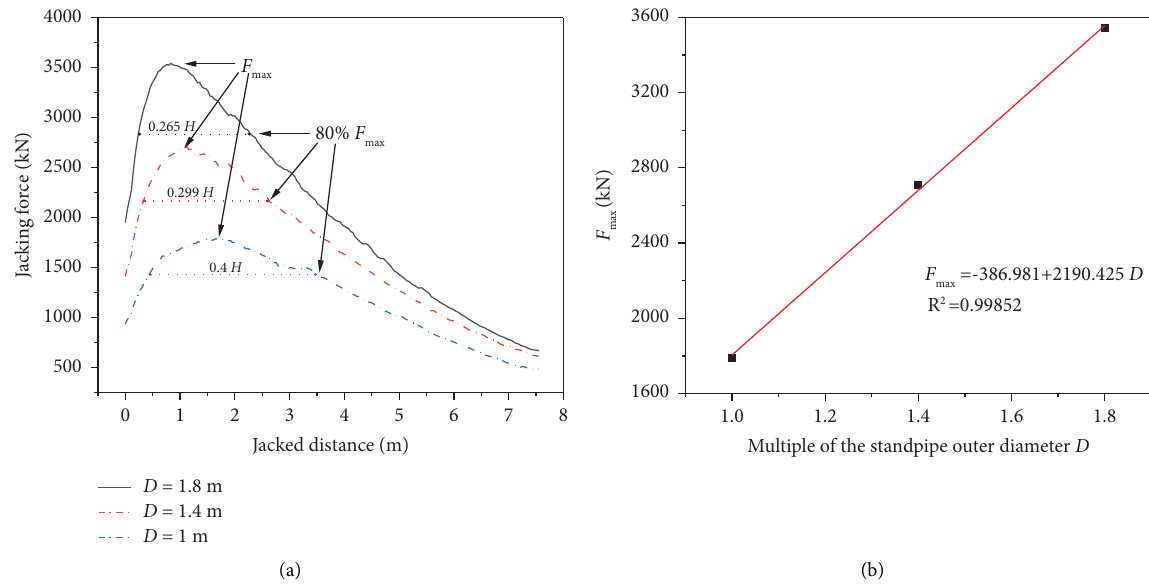
Figure 9: Infuence of the standpipe outer diameter on jacking force. (a) Infuence of the standpipe outer diameter on jacking force. (b) Relationship between the standpipe outer diameter and maximum jacking force.